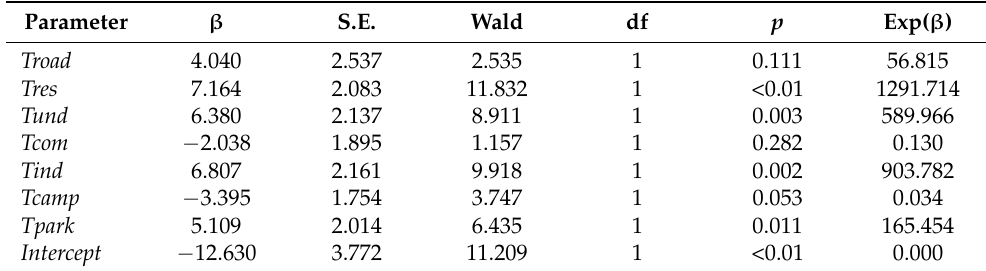
Table 5. Parameter values for the top binary logistic regression model of the relationship between habitat attributes and visits to camera stations by San Joaquin kit foxes or red foxes in Bakersfield, California, during 2015–2021.